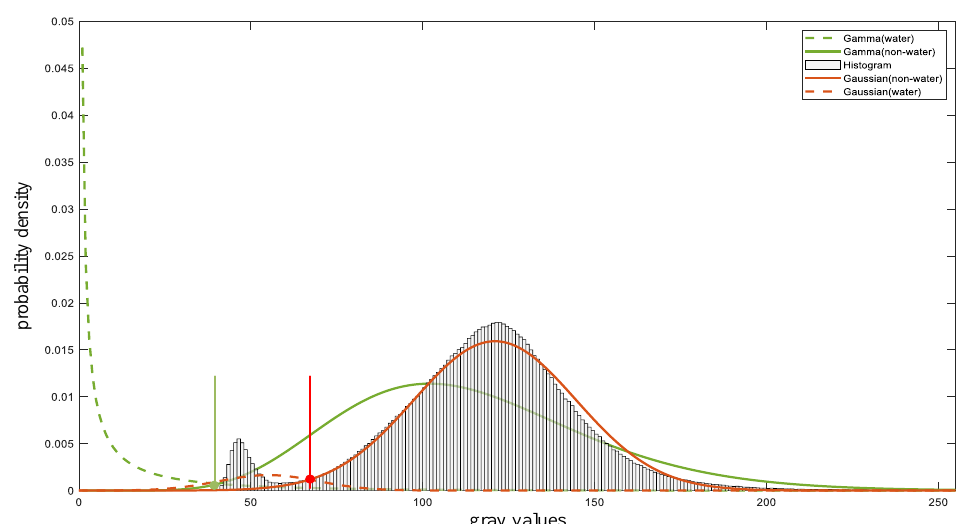
Figure 10. The comparison of Gamma distribution (green) and Gaussian distribution (red) for fit- ting Table 4. Algorithm complexity.